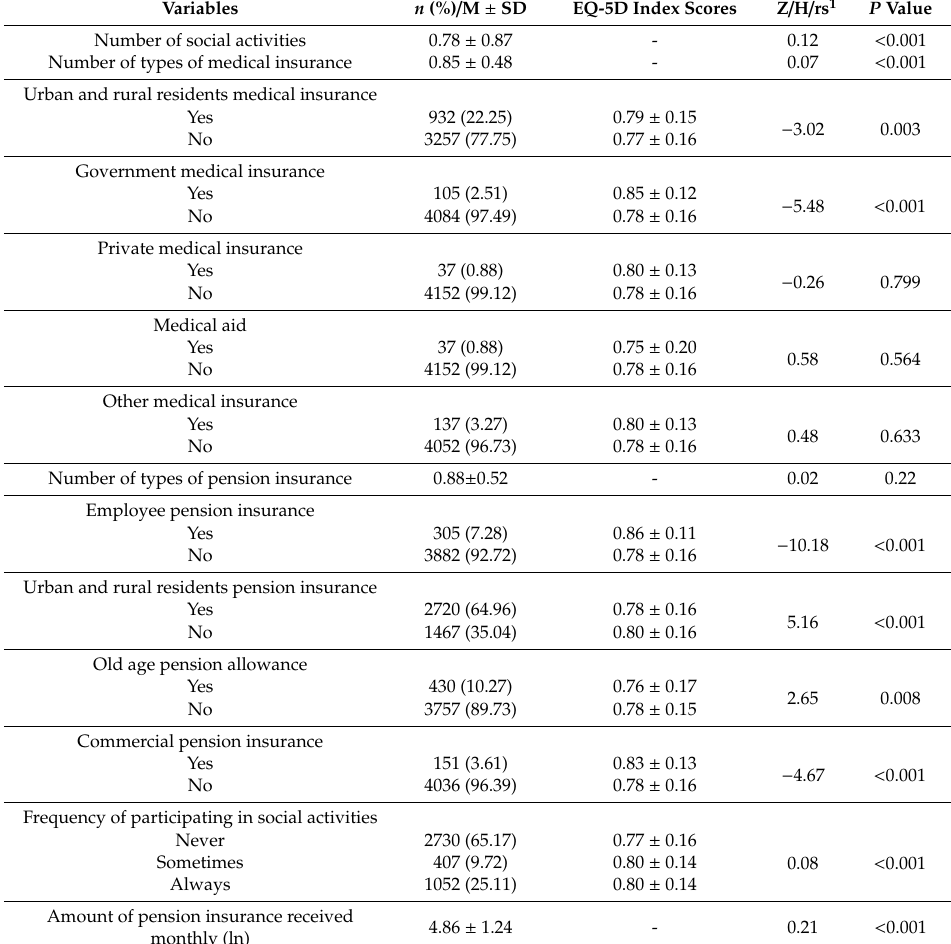
Table 2. The relationships between HRQOL and the quantity and quality of formal social support.